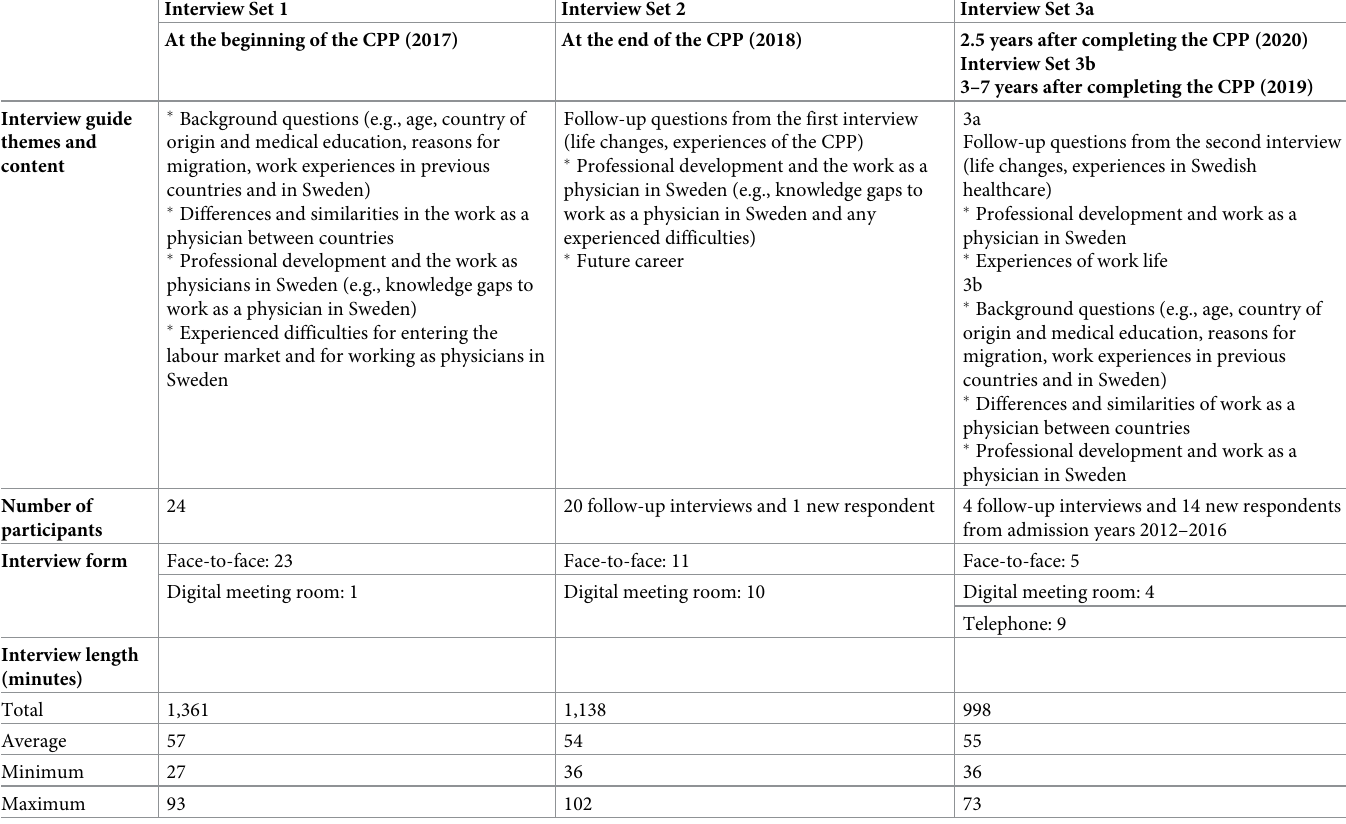
Table 1. Overview of interview sets and themes in the interview